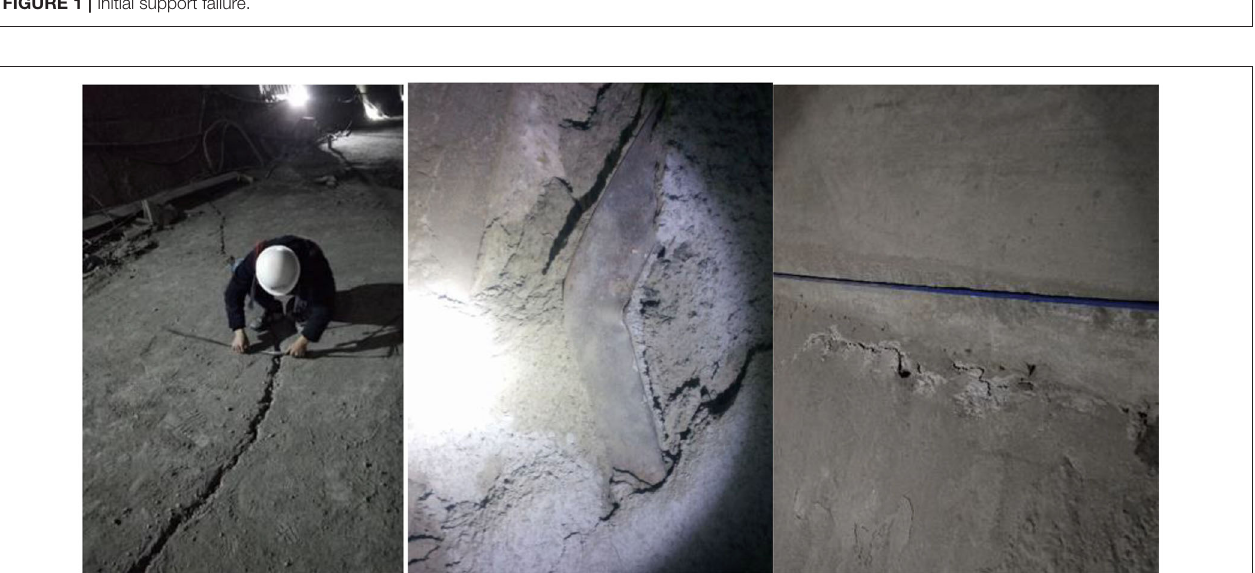
FIGURE 2 | Deformation of major tunnel